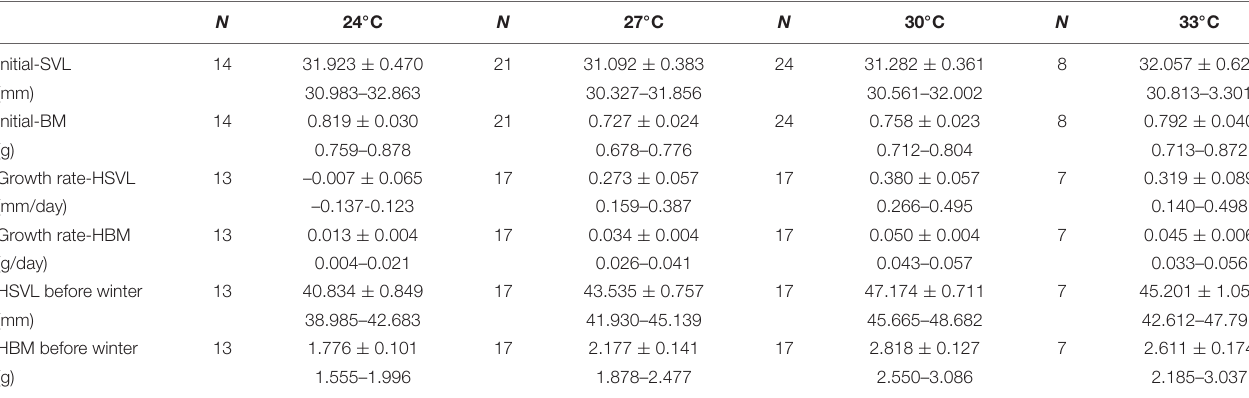
TABLE 1 | Initial body size (SVL and BM), growth rate of hatchlings (SVL and BM), and hatchlings body size (SVL and BM) before winter under different temperatures.